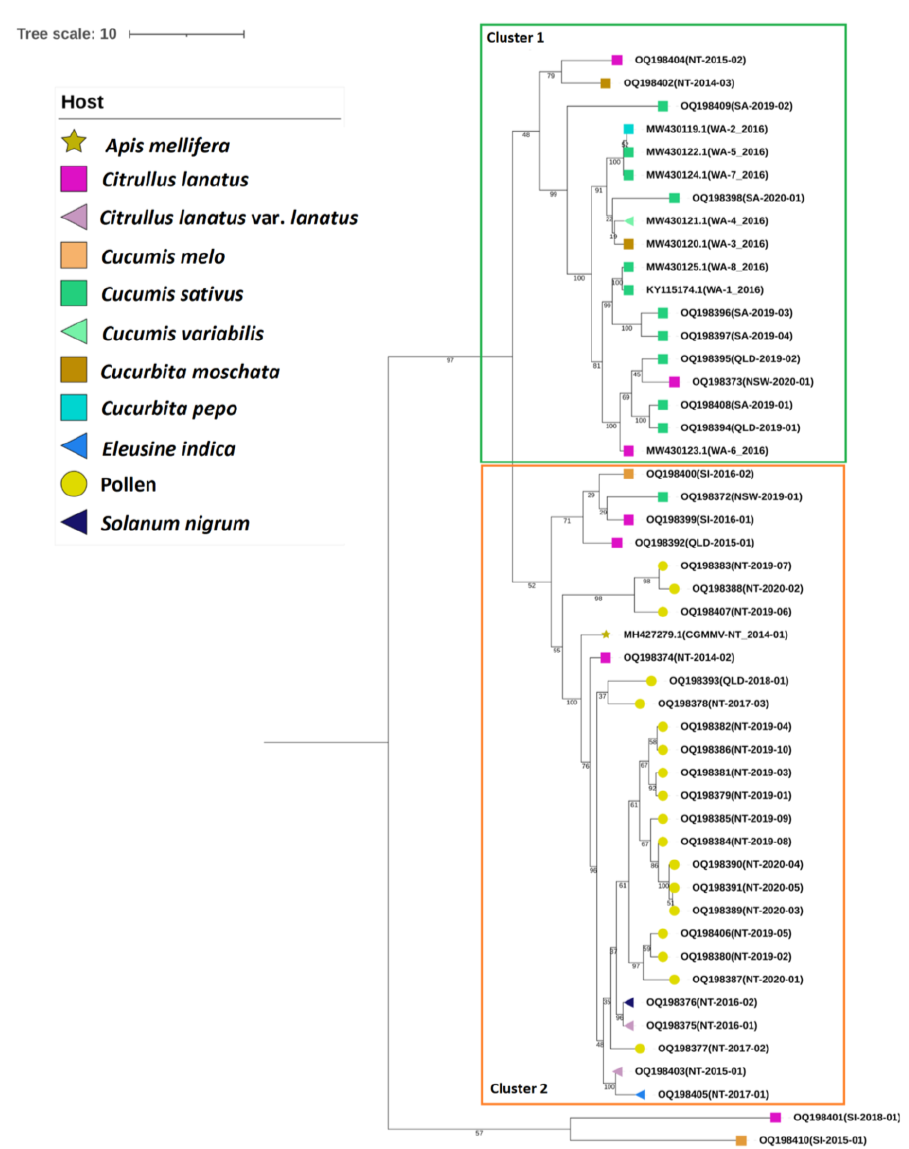
Figure 4. Bayesian maximum-clade-credibility tree estimated for the complete coding region nucleotide sequences of all Australian cucumber green mottle mosaic virus (CGMMV) isolates in sub-clade 2C and seed interception isolates in sub-clades 2C and 2D. The tree was created using BEAST v1.10.4 [44] using the following analysis settings: model—Tamura–Nei; rates among sites—gamma distributed with invariant sites. Tree scale—branch lengths measured by number of substitutions per site. Branch values are posterior probabilities of having a changepoint. Isolate hosts are shown using node symbols (key included).